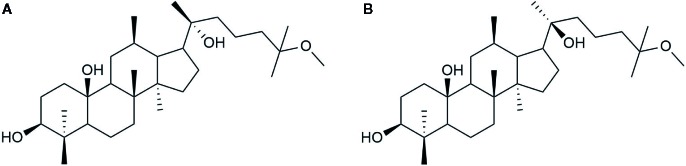
Chemical structure of (A) 20(R)-25-OCH3-PPD (B) 20(S)-25-OCH3-PPD.